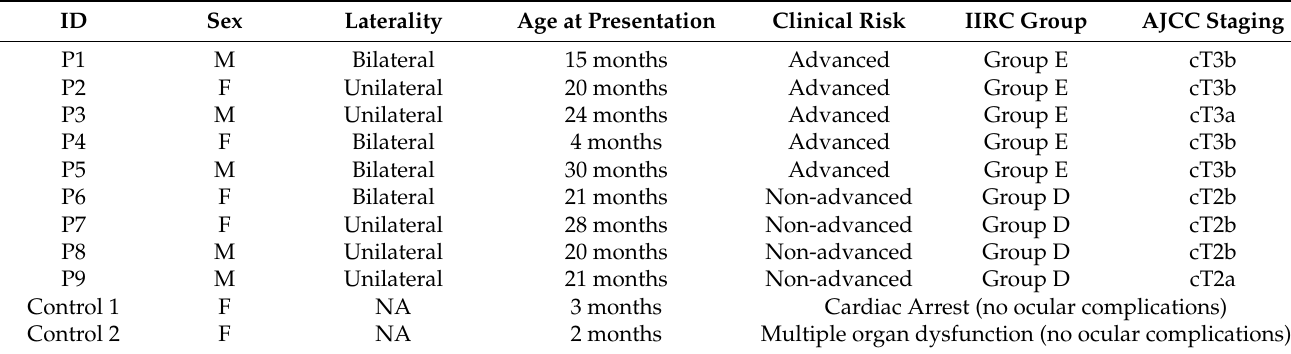
Table 1. Clinical and histopathological details of